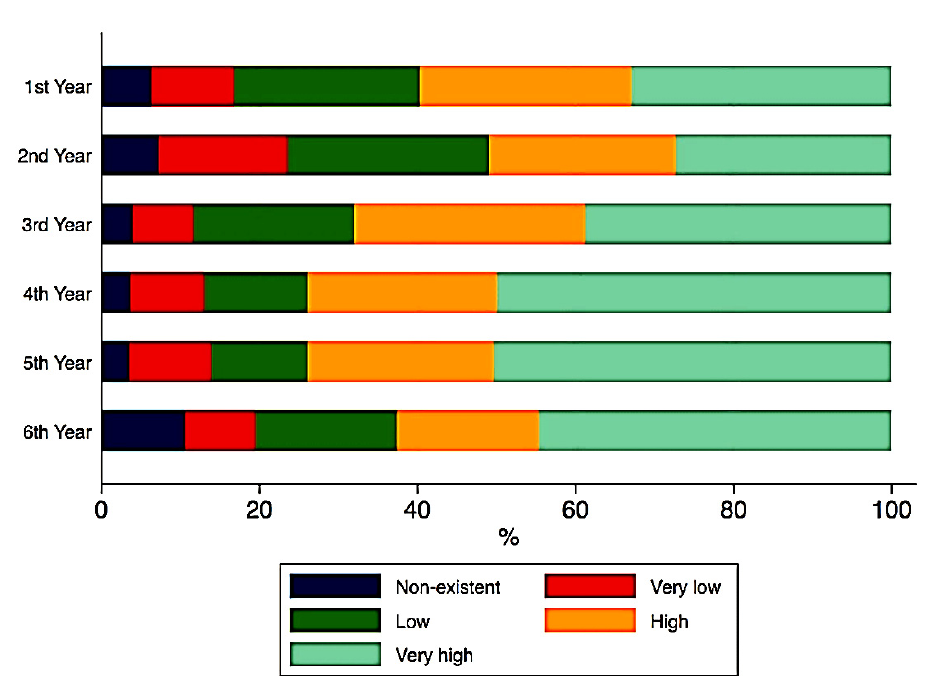
Figure 5. Future professional